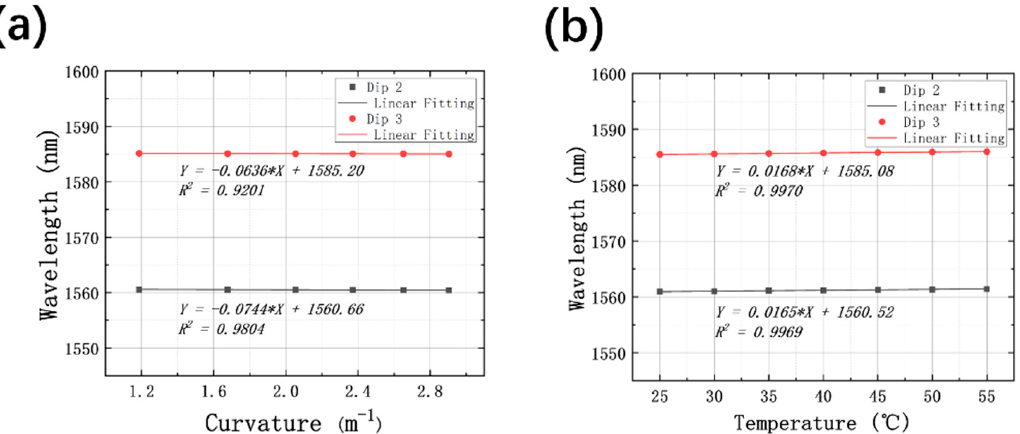
Figure 9. ( a ) Recalculated relationship between the wavelength of resonant dips and curvature of Dip 2 and Dip 3; ( b ) recalculated relationship between the wavelength of resonant dips and temperature of Dip 2 and Dip 3.